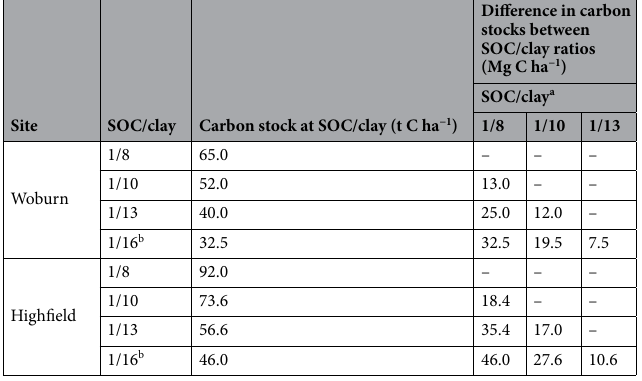
Table 4. Carbon stock differences between SOC/clay thresholds for Woburn and Highfield soils. Carbon stock calculated to 25 cm depth. a Dashes indicate not applicable. b Typical of arable management in the two